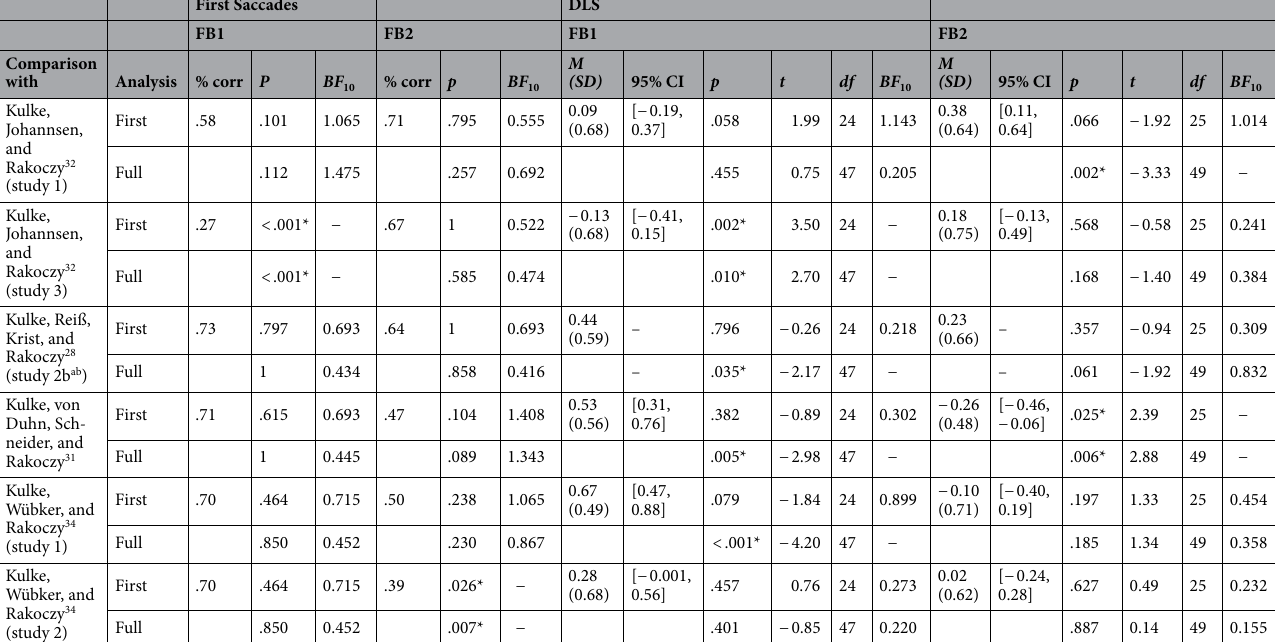
Table 1. Descriptive Statistics of first saccades and DLSs in previous studies and results of binomial tests (first saccades) and one-sample t-tests (DLSs) comparing the proportion of correct first saccades and the DLSs